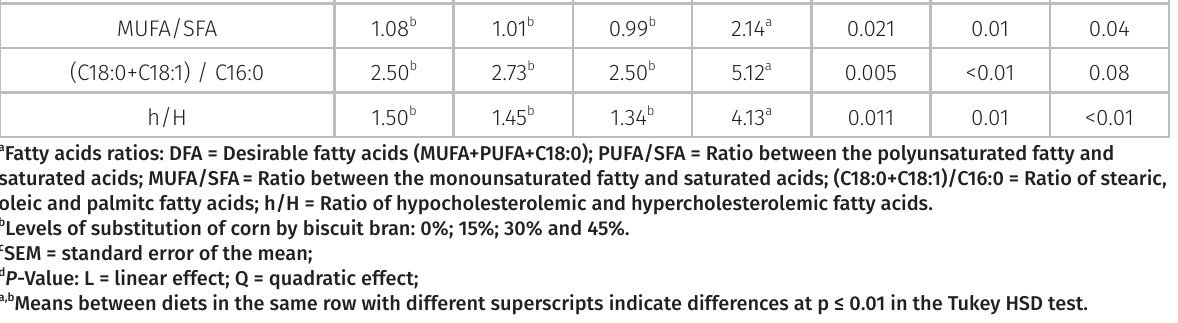
Fatty acids ratio